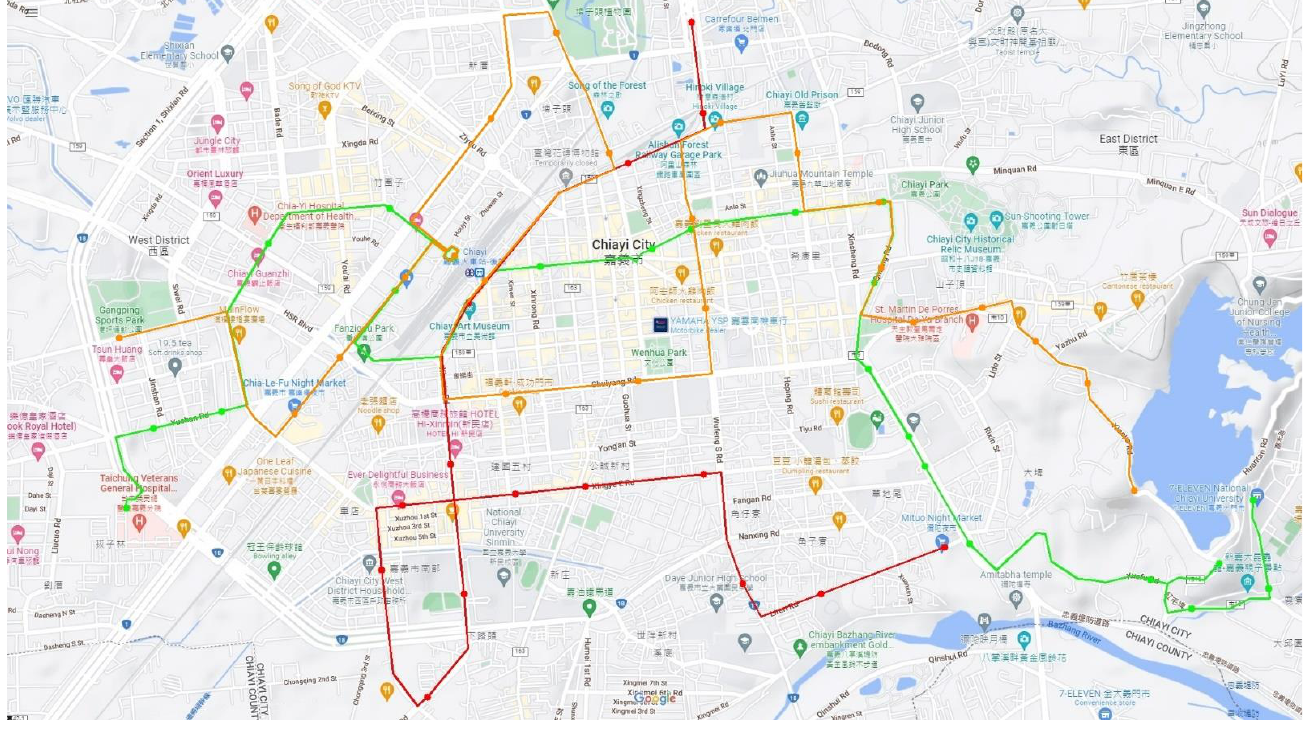
Figure 2. Bus routes in Chiayi city. Table 3. The parameters in the experiment.